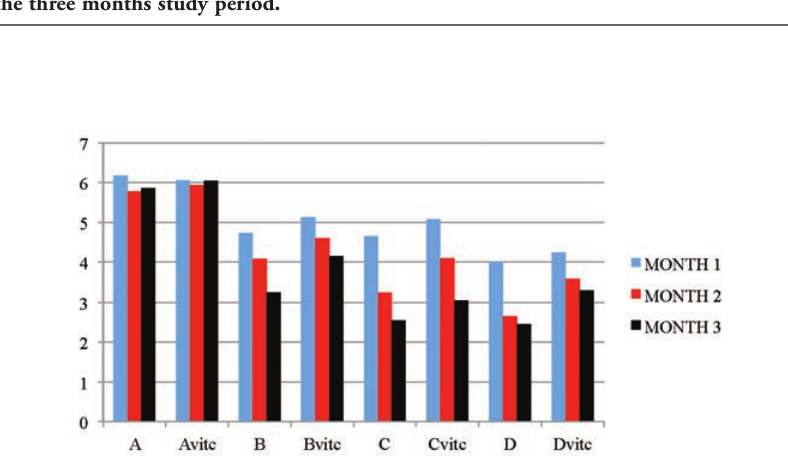
Figure 6. The mean serum glucose (mmol/L) values of the different subgroups during the three months study